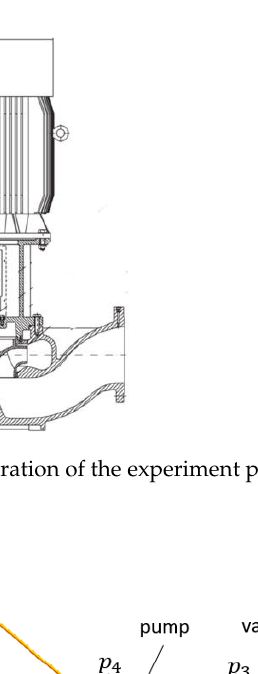
Figure 18. Illustration of the experiment pump (vertical pipe pump) [79].